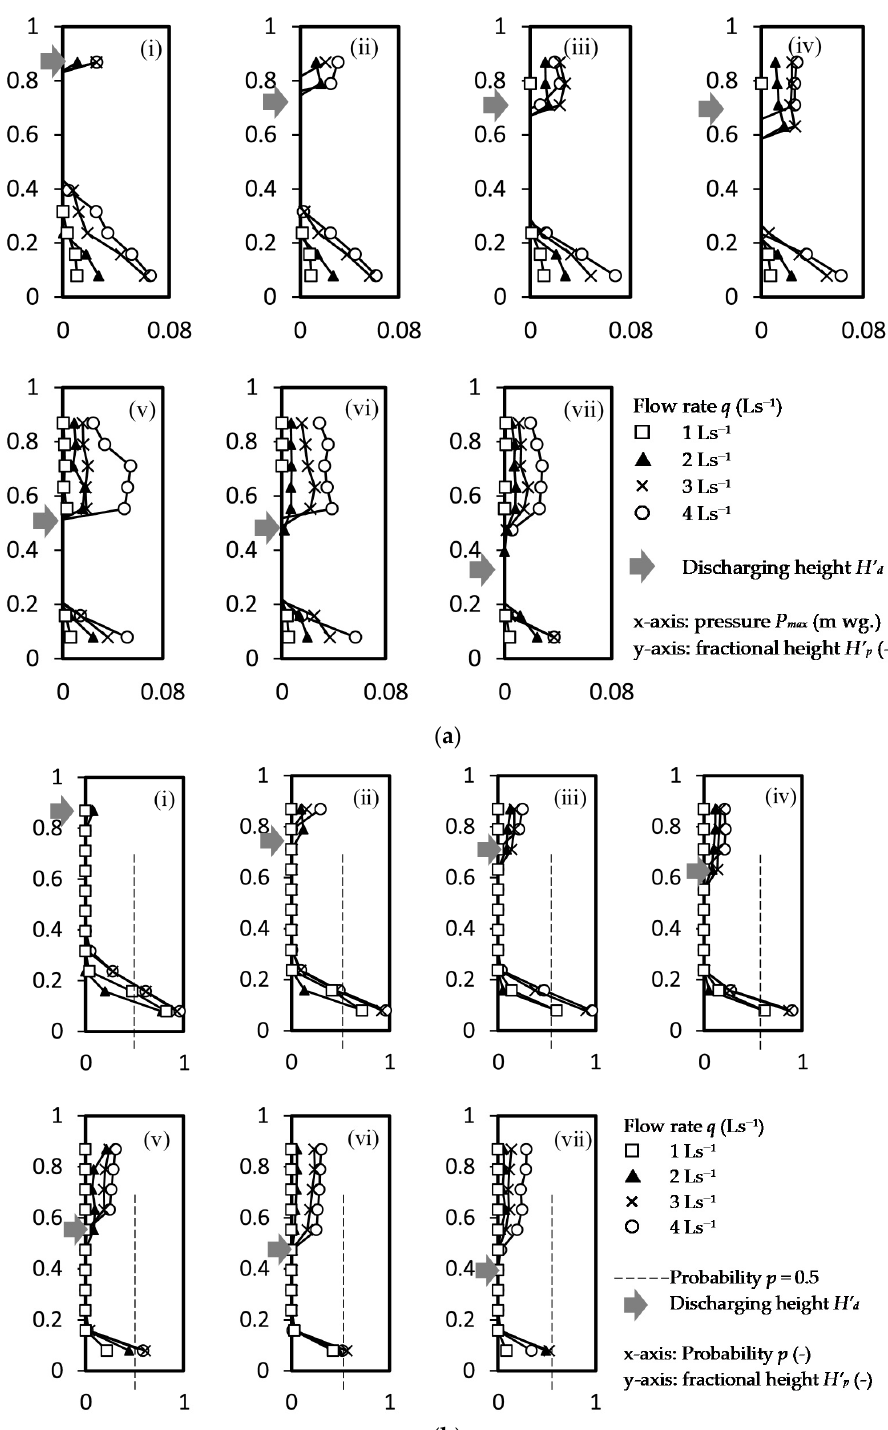
Figure 4. Positive air pressure within a discharging drainage stack ( H = 38 m) at a normalized stack height H’ p with a normalized stack discharging height H’ d . ( a ) Maximum air pressure; ( b ) probability of positive air pressure.